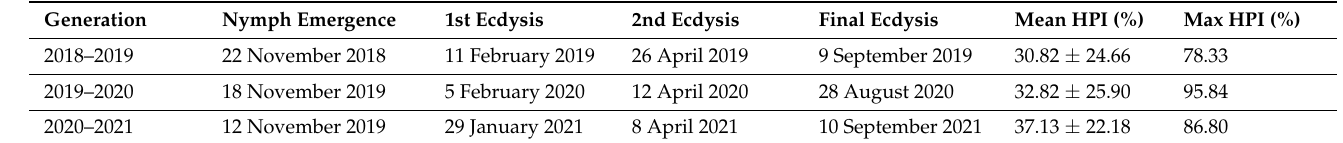
Table A1. Summary statistics of first detections of notable life history milestones and feeding activity across Marchalina hellenica instars of a given generation. ± represents one standard deviation. Generation Nymph Emergence